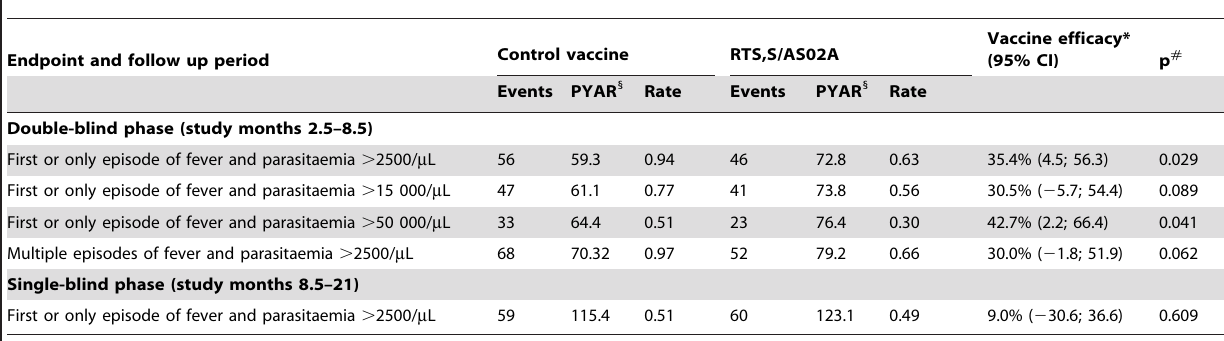
Table 1. Vaccine efficacy against clinical malaria in cohort 2 (ATP